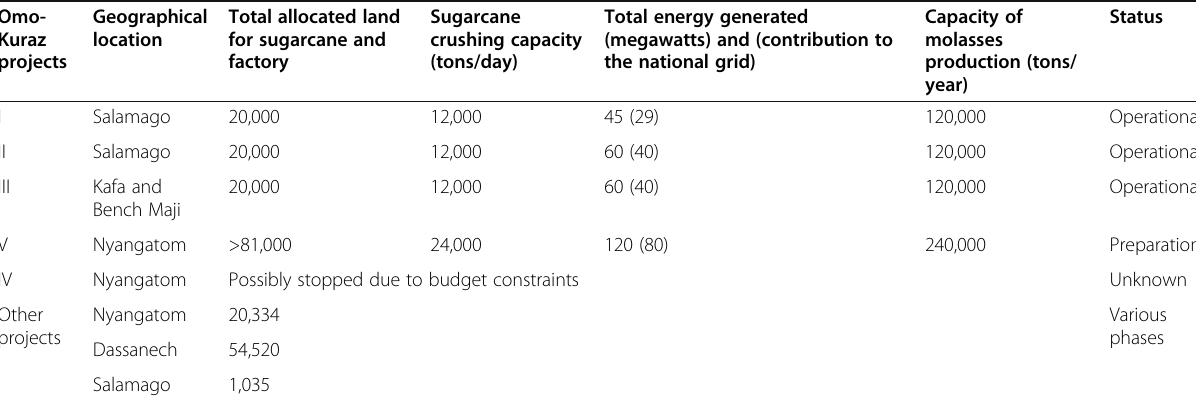
Table 1 Omo-Kuraz sugar industry profiles (ESC and EIC)